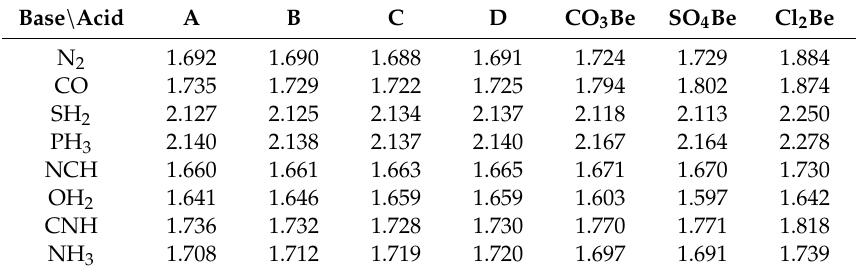
Table 2. Intermolecular distance (Å) between the Be atom and the basic site of the Lewis bases. Base \ Acid A B C D CO 3 Be SO 4 Be Cl 2 Be N 2 1.692